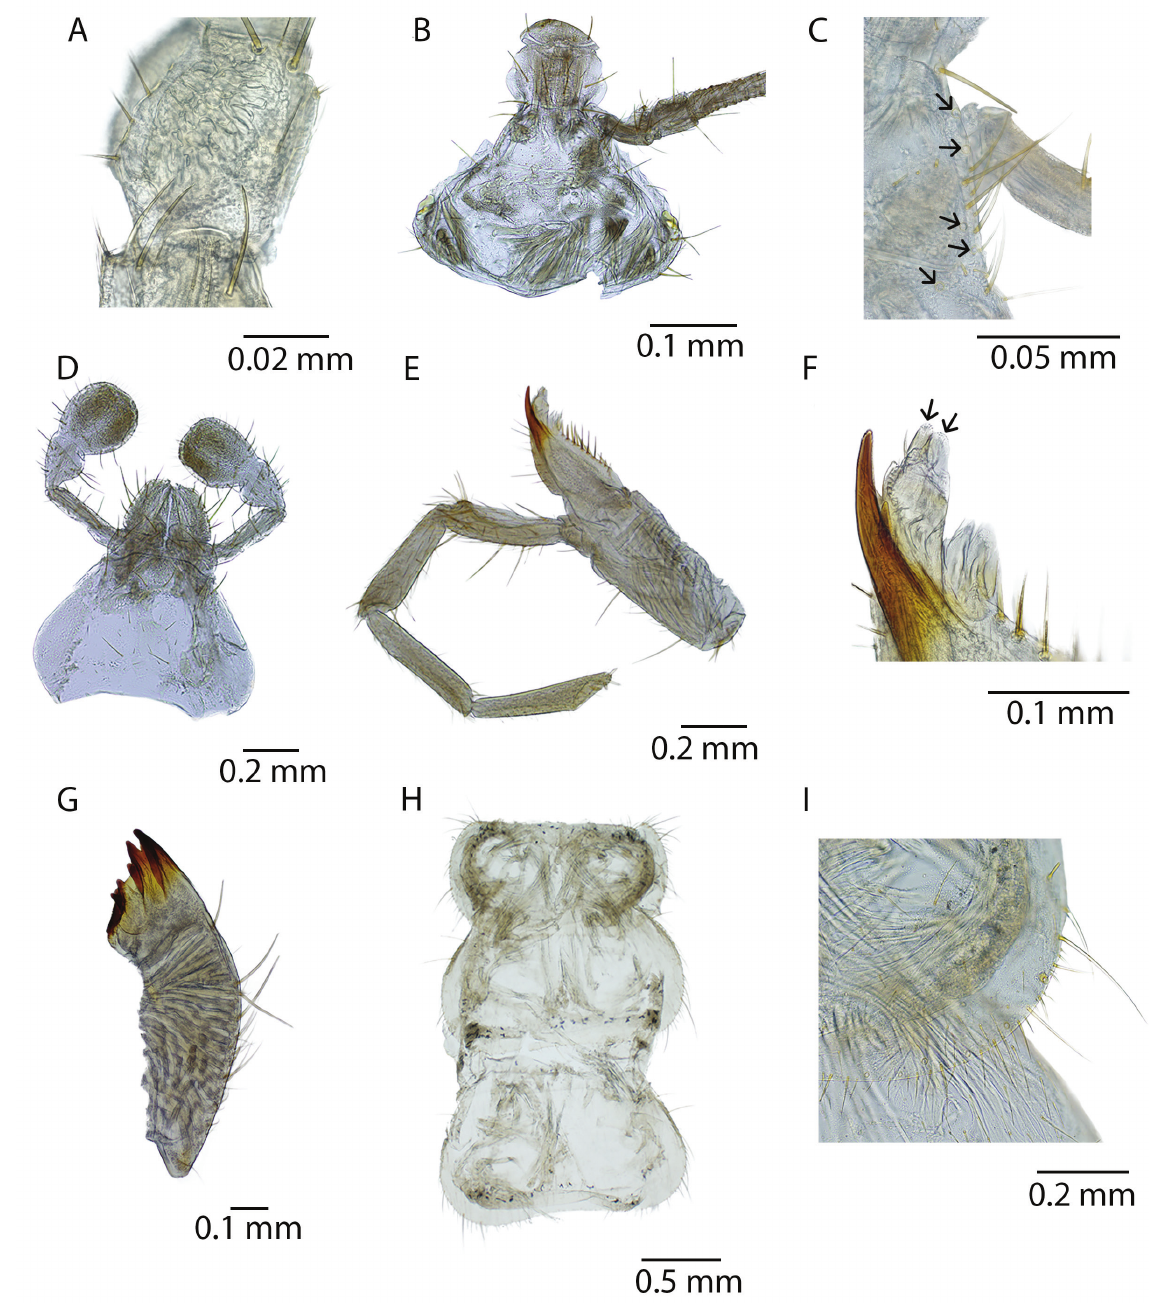
Fig. 1. Anelpistina taninuli sp. nov. Holotype, adult ♂. A . Pedicellus (outside lateral view). B . Head. C . Border of insertion of antenna (arrows point at alveoli where macrochaetae have fallen). D . Labium. E . Maxilla. F . Apex of lacinia and galea. Galea with two conules of different widths. G . Mandible. H . Nota. I . Border of